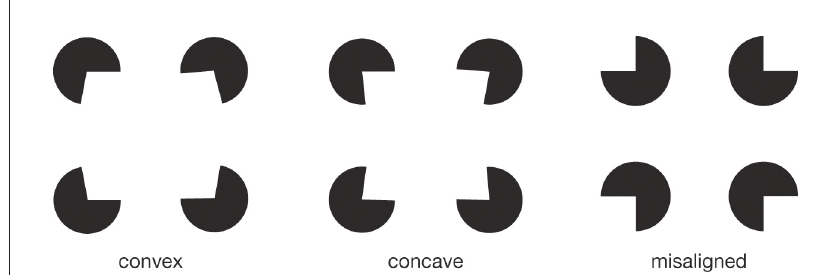
Figure 1 | Kanizsa stimuli used by Maertens et al. (2008). Illusory contours were generated by inducers (black “pack-men”) shown at different angles. The task was to judge whether the illusory contour was convex or concave. As control condition, the pack-men were misaligned which does not induce illusory